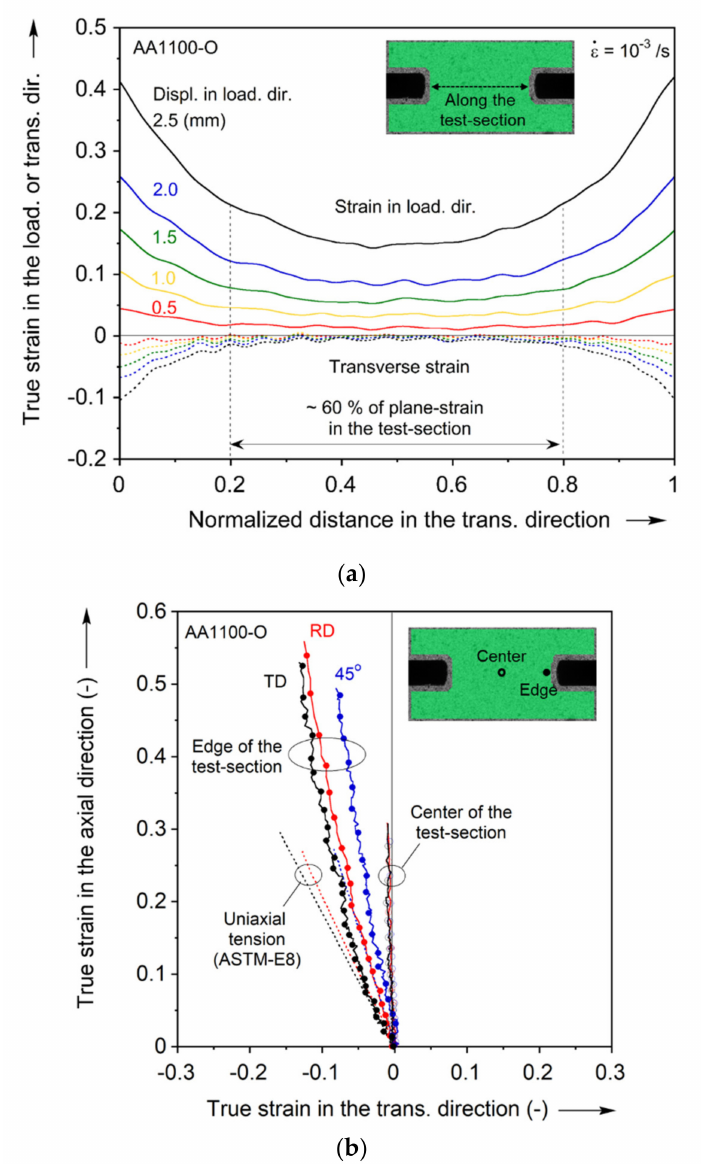
Figure 6. Experiment for plane-strain tension: ( a ) Variation of the loading and transverse direction strains along the test-section, and ( b ) strain paths probed at local material points near the edge and the center of the